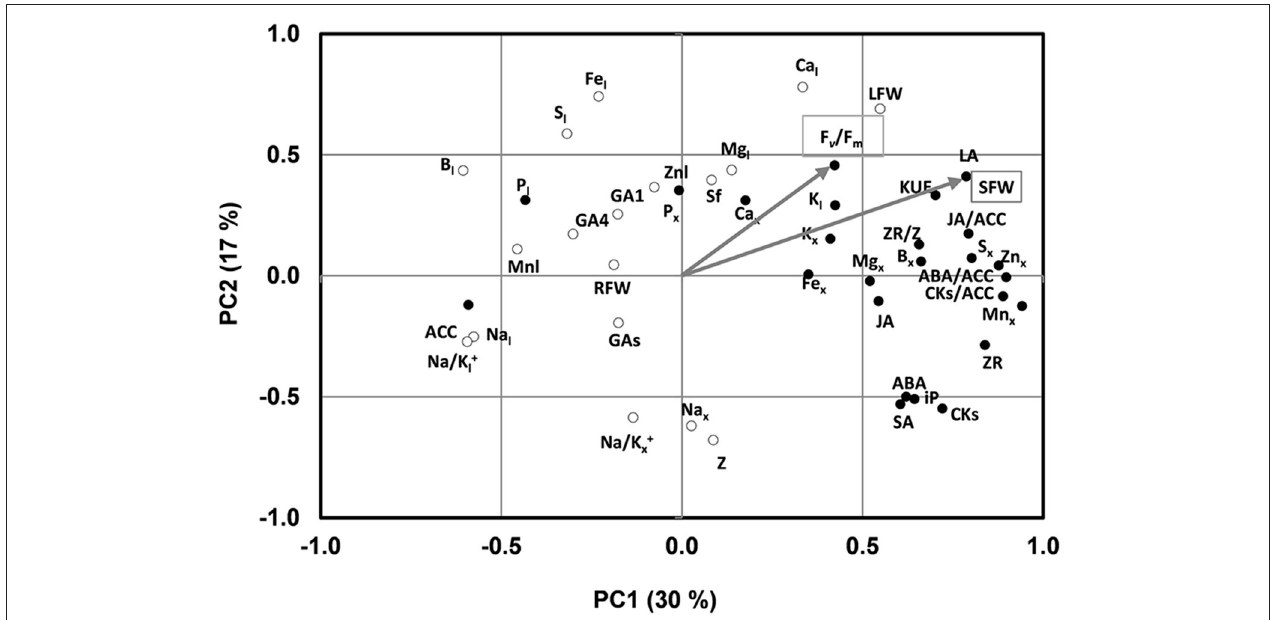
FIGURE 2 | Two axes of a principal component (PC1, PC2) analysis under low K conditions showing shoot fresh weight (SFW) and F v /F m trait vectors (indicated by arrow) and the position of all variables (denoted by abbreviations) studied under low K conditions. Hormonal parameters in the xylem sap: ZR, Z, iP, CKs, ACC, ABA, JA, SA, GA 1 , GA 4 , GAs; Hormonal ratios: ZR/Z, CKs/ACC, ABA/ACC, JA/ACC; Ionic parameters in the xylem sap: K x , Na x, P x , Mg x , S x , Ca x , Na x , Zn x , Mn x , Fe x , B x , Na/K x ; ionic parameters in the leaf: K l , Na l , P l , Mg l , S l , Zn l , Mn l , Fe l , B l , Na/K l ; biomass related parameters and others: SFW, shoot fresh weight; RFW, root fresh weight; LFW, leaf fresh weight; LA, leaf area; sf, sap flow; KUE, K use efficiency. The black and white circles indicate the variables belong to the cluster 1 and 2, respectively.